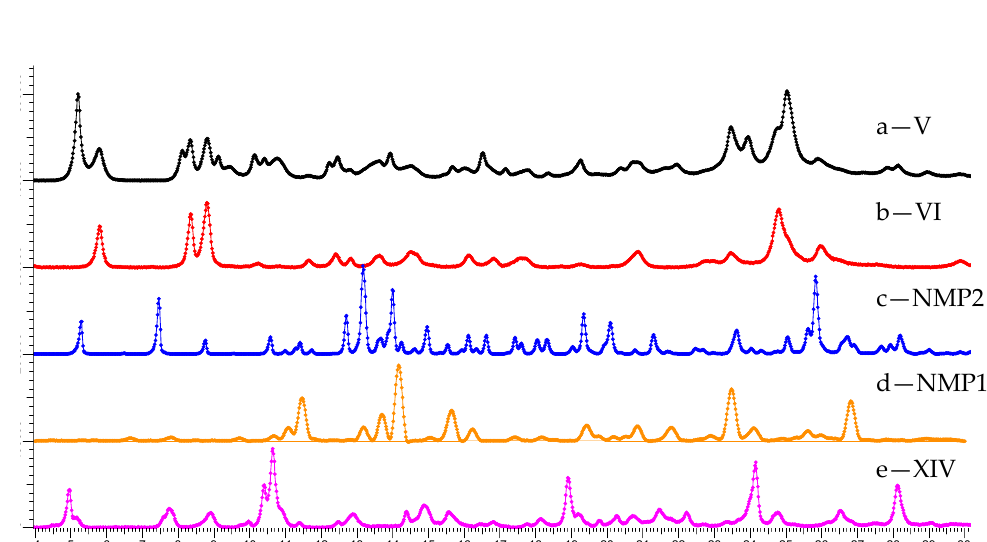
Figure 5. Raw XRPD data for solvated Eltrombopag free acid species: ( a ) Form V; ( b ) Form VI; ( c ) Form NMP (2:1) solvate; ( d ) NMP (1:1) solvate; and ( e ) Form XIV in the low-angle (4–30° 2 θ ) range. x and y axes: 2 θ range, ° and intensities (a.u.), respectively. These raw data clearly manifested the high crystallinity (narrow Bragg peaks) of the NMP2 crystal phase, while broader peaks were observed for all other solvates.